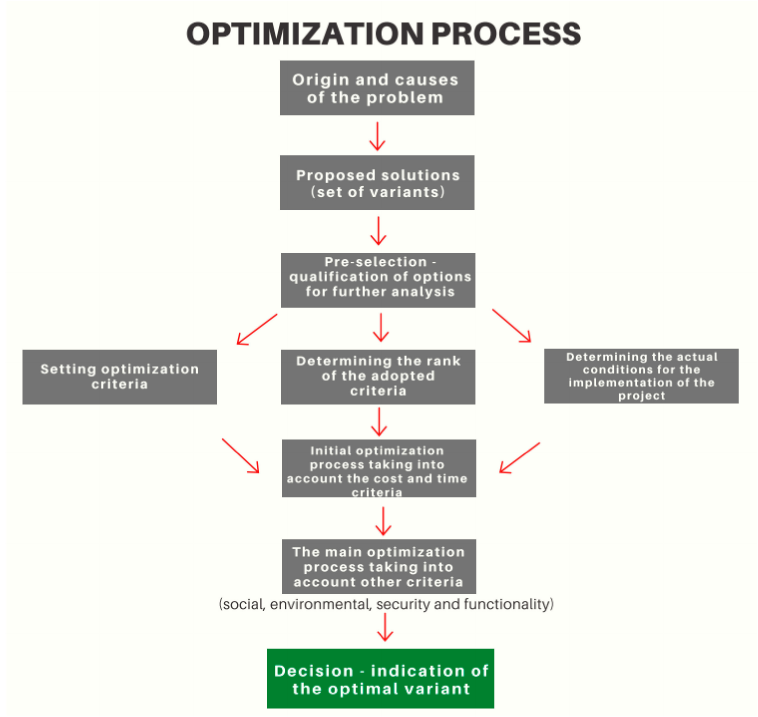
Figure 9. Flow chart of optimization